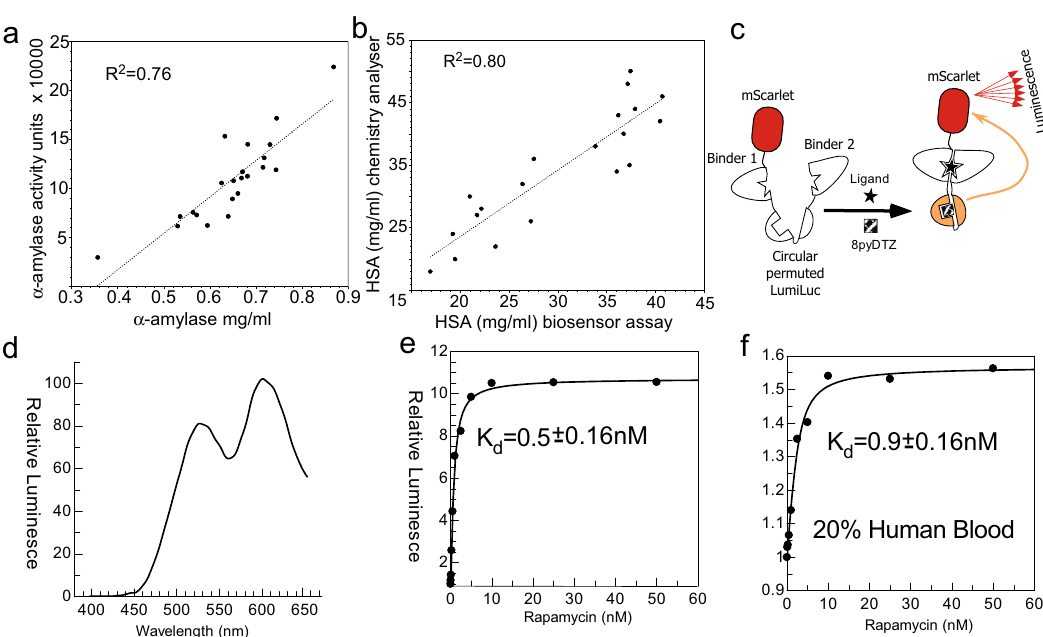
Fig. 3 Quanti fi cation of biomarkers in human biological fl uids using biosensors based on circularly permutated version of LumiLuc. a Quanti fi cation of α -amylase in samples of human saliva using solution assay based on cpLumiLuc biosensor ( X -axis) and its comparison with and its comparison with the clinical α -amylase activity assay ( Y -axis). b Quanti fi cation of HSA concentration in serum of human donors using cpLumiLuc HSA biosensor ( X -axis) or clinical chemistry analyser ( Y -axis). c Schematic representation of the BRET biosensor based on cpLumiLuc. d Emission scan of the solution of 1 nM of LumiLuc biosensor, 10 nM Rapamycin, 30 μ M 8pyDTZ, e titration of 1 nM solution of LumiLuc biosensor and 30 μ M 8pyDTZ with increasing concentrations of rapamycin. The emission was collected at 595 – 620 nm. f As in c but using the sample supplemented with 20% lysed human blood. Source data are provided as a Source Data fi